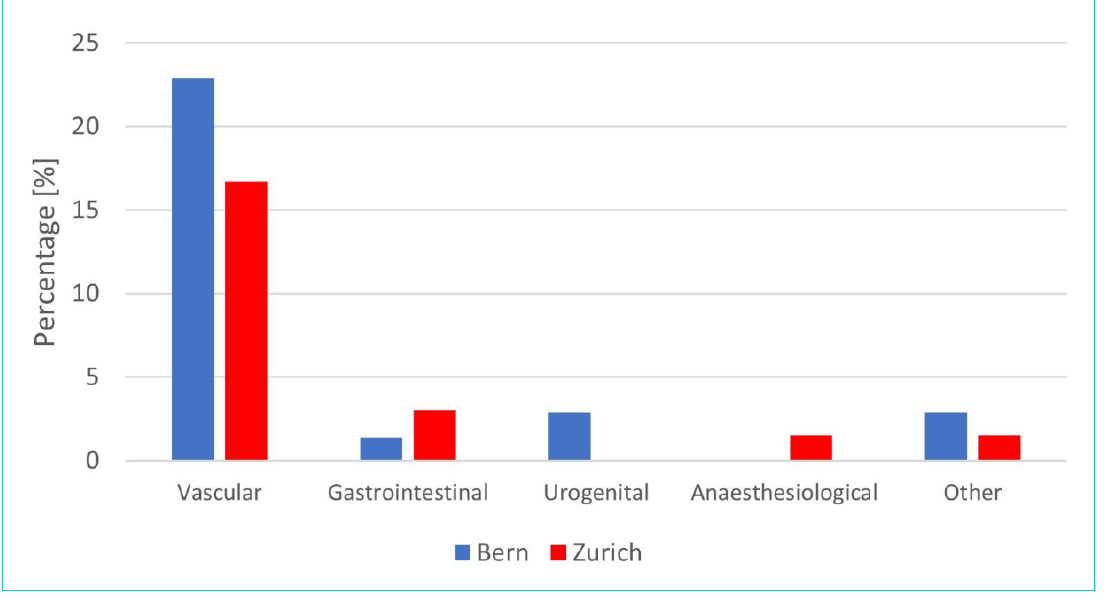
Figure 2: Intraoperative complications during post-chemotherapy retroperitoneal lymph node dissection by centre.